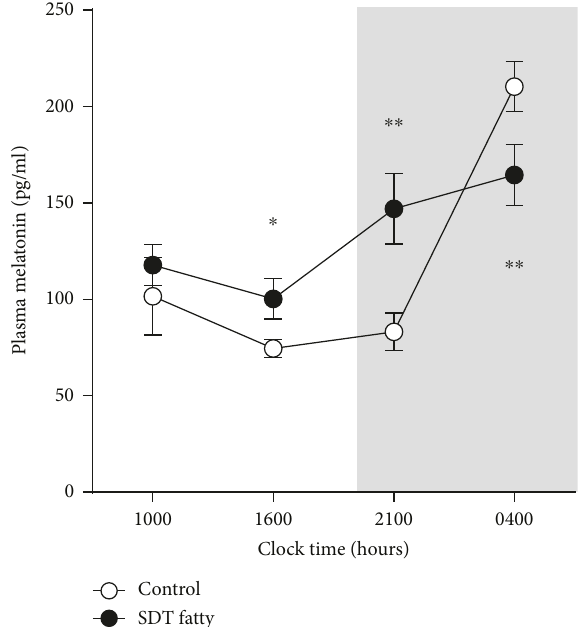
Figure 3: Circadian rhythm of plasma melatonin concentrations in control Sprague – Dawley (SD) and Spontaneously Diabetic Torii (SDT) fatty rats. Data are mean ± SEM ( n = 5 in each group). ∗ P < 0 05 and ∗∗ P < 0 01 compared with the control group at the same time point (two-way ANOVA with post hoc Aspin- Welch